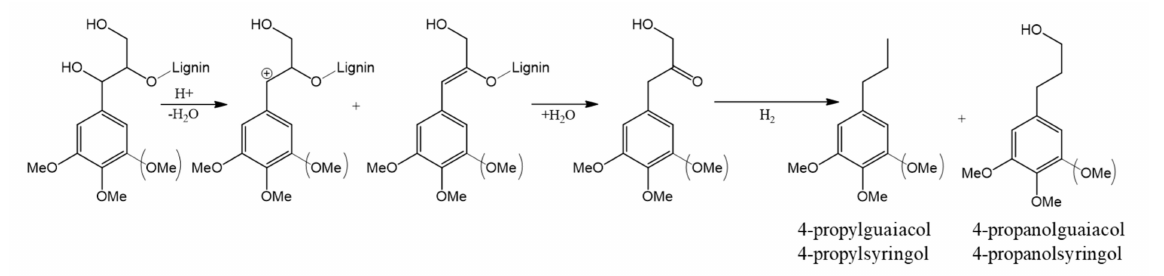
Figure 2. Scheme of lignin hydrolysis via cleavage of β -O-4 bonds and hydrogenation of intermediates in the presence of Ru-containing catalysts